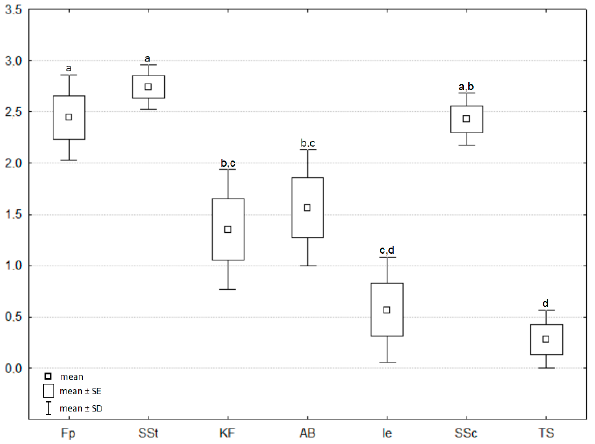
Figure 3. Shannon Diversity Index H ′ calculated [±SD and SE] for the dataset of the number of macrofungal species found in the studied plant communities in the years 2010–2013. Letters on the chart indicate the results of one-way ANOVA and post hoc Tukey test analysis. Variables marked with the same letter did not differ from one another significantly, whereas significant differences ( p < 0.05) occur between groups marked with different